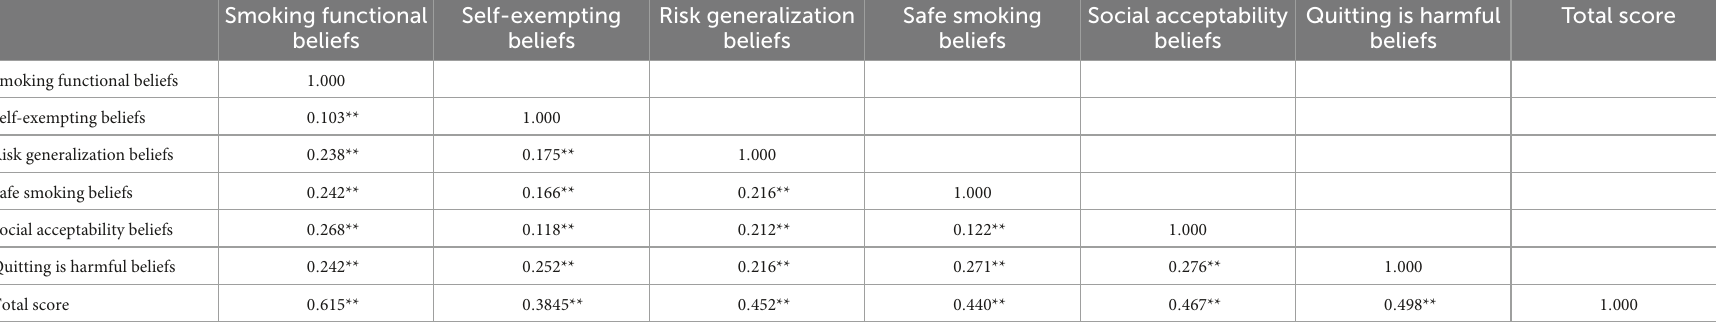
TABLE 6 Correlation between each dimension and total score of simplified smoking rationalization belief scale.